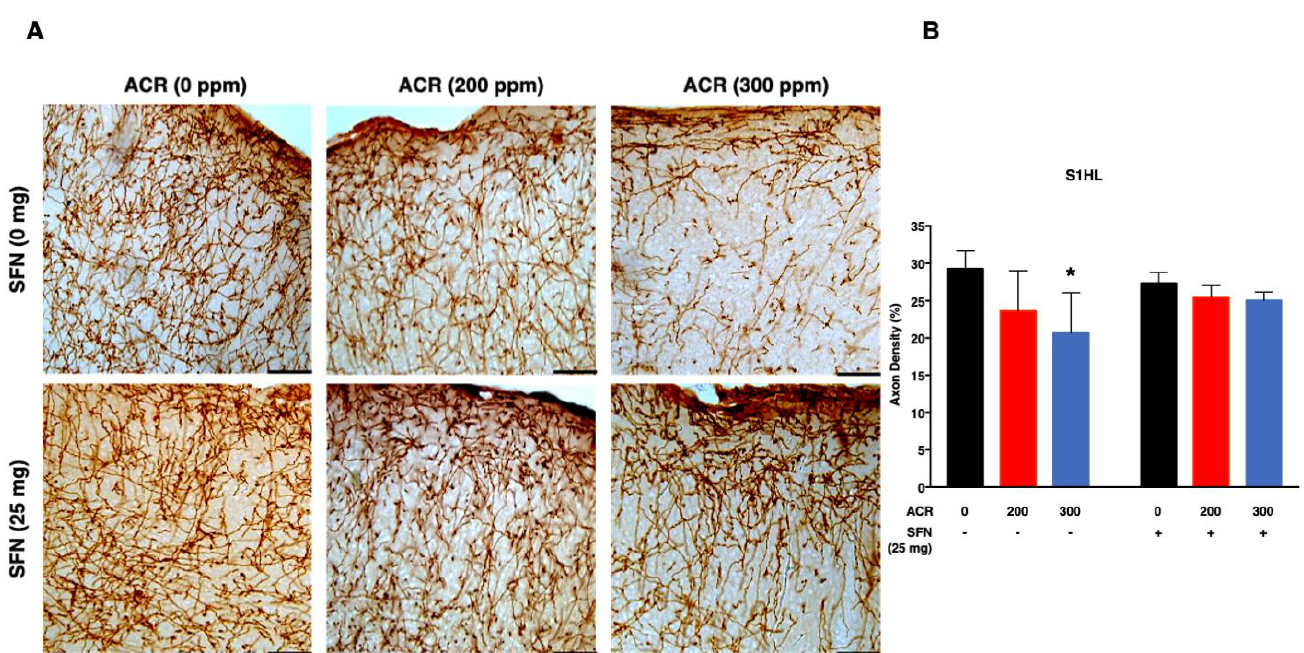
Figure 3. Representative photomicrographs ( A ) and density ( B ) of noradrenaline transporter (NAT)-immunoreactive axons in the hindlimb primary somatosensory cortex (S1HL) of mice following exposure to acrylamide and treatment with sulforaphane. Data are mean ± SD. * p < 0.05, compared to the corresponding control (by ANOVA followed by Dunnett’s multiple comparison) Scale bars = 40 µm; n = 4.